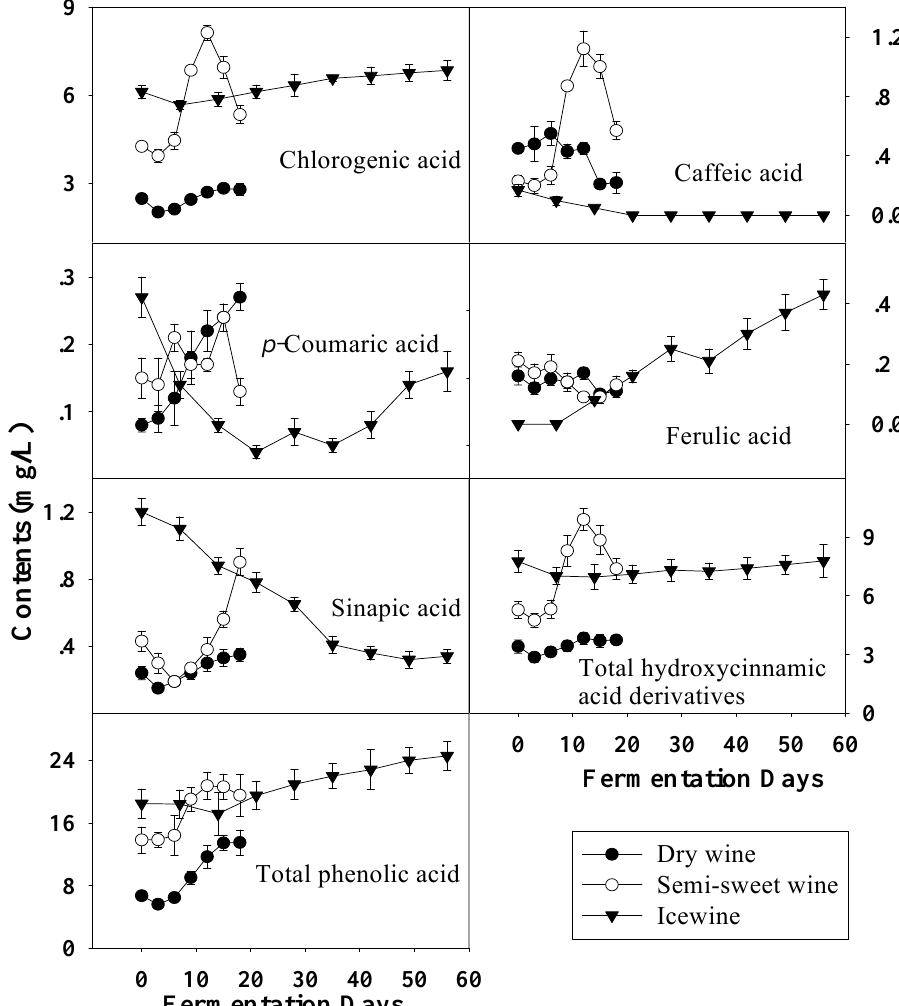
Figure 6. Evolution of hydroxycinnamic acid derivatives and total phenolic acid during the fermentation of dry wine, semi-sweet wine and